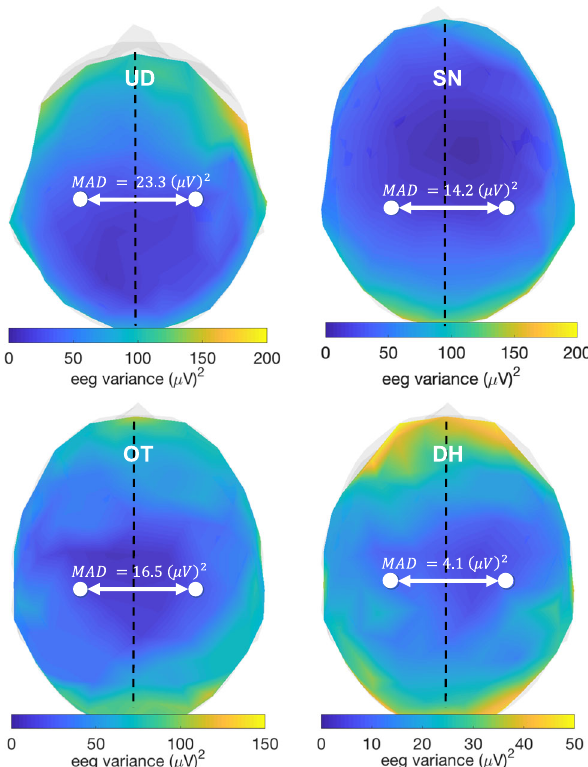
Fig. 4 Quanti fi cation of hemispheric symmetry of scalp average power. Mean absolute difference of scalp average power (MAD) is reported for a healthy control participant (DH), in comparison to the three patients who have resected brain regions (UD, SN, and OT). The control participant shows substantially smaller MAD compared to the three patients with cortical regions of